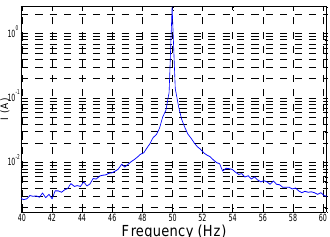
Fig. 7. 8-level DWT of the startup current for the unloaded healthy machine.